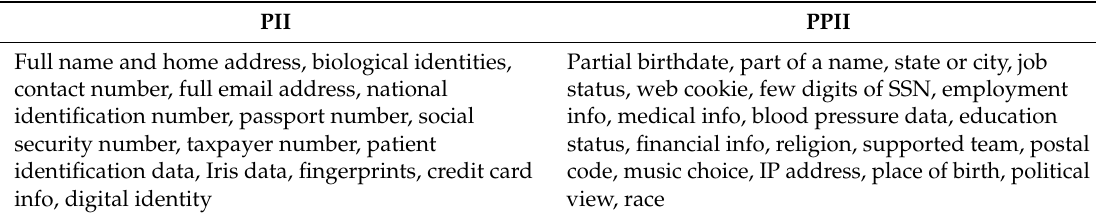
Table 1. Personal information (personally identifiable information (PII) and potential personally identifiable information